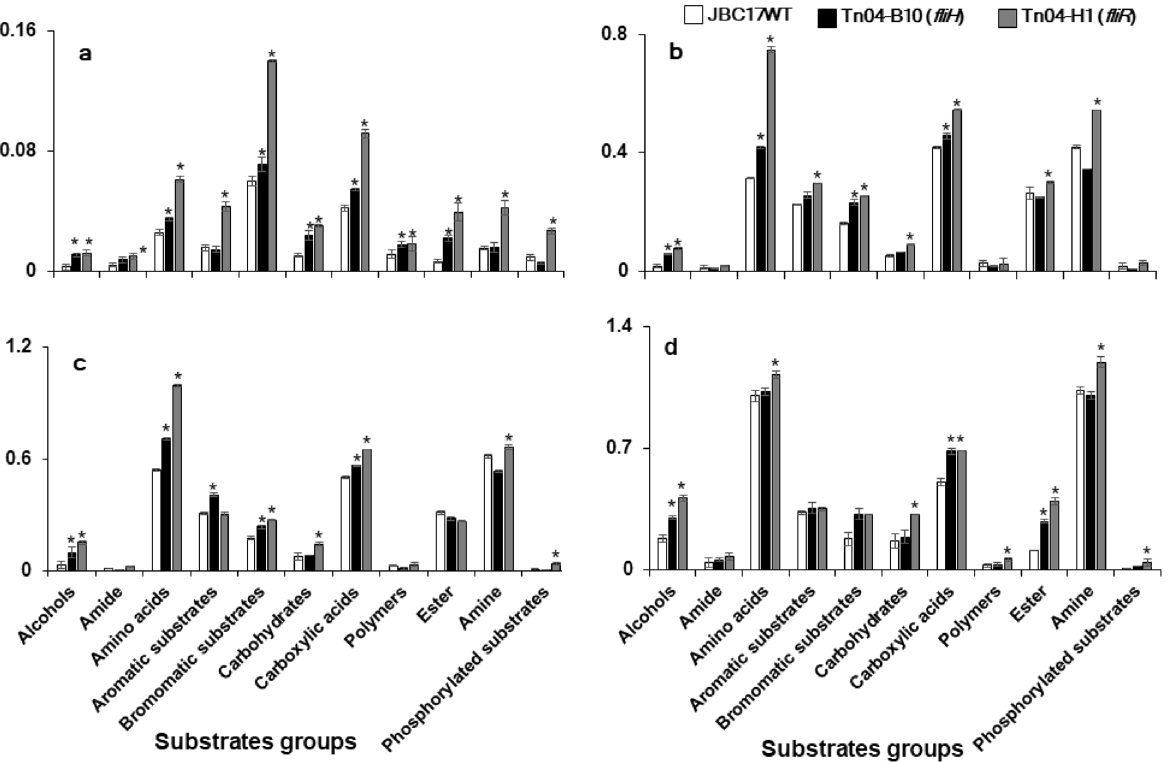
Figure 6. Average well color development (AWCD) and utilization of various groups of carbon substrates by Pseudomonas putida JBC17 and flagella-related mutants. P. putida JBC17 (JBC17WT) and its flagella-deficient mutants, Tn04-B10 ( fliH ) and Tn04-H1 ( fliR ), were incubated in Biolog GN2 microplate. AWCD of 95 carbons were recorded at OD 600 at 6 h ( a ), 16 h ( b ), 24 h ( c ), and 48 h ( d ) and compared to the wild type. Data are presented as the mean ± SD of three replicates, and values marked by an asterisk (*) are significantly different from the wild type in absorbance at P < 0.05 according to Student’s t-test.